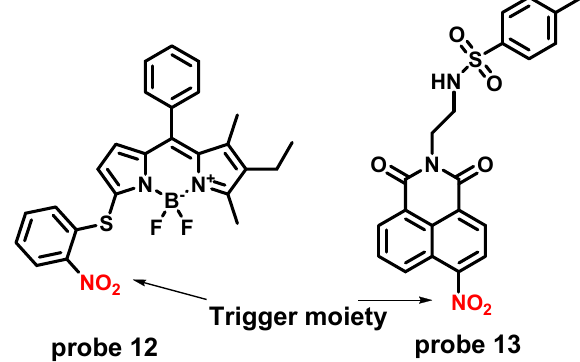
Hela and HepG2 cell and HepG-2 tumor-bearing mice model. Probe 13 was developed for monitoring NTR in endoplasmic reticulum.